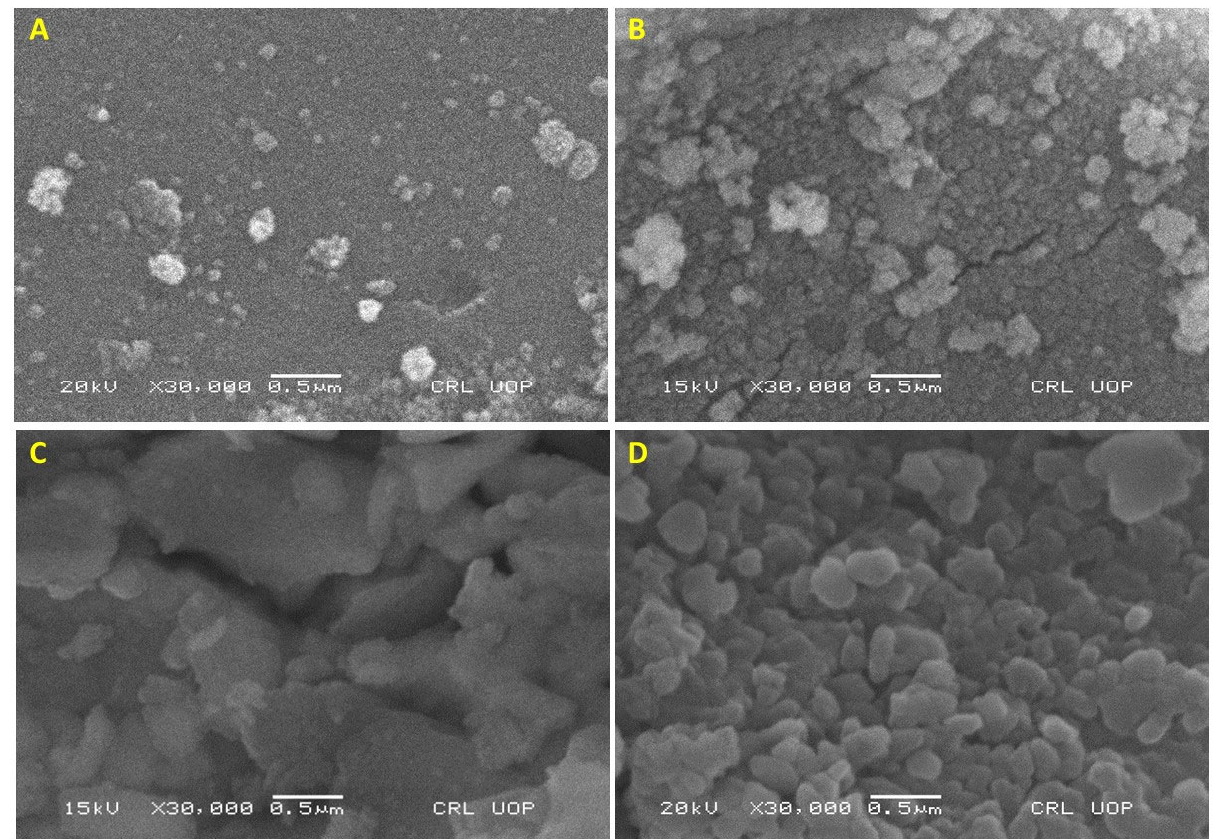
Figure 2. SEM micrographs of NiO ‐ SnO 2 NCs calcined at ( A ) 100 °C, ( B ) 300 °C, ( C ) 600 °C, and ( D ) 900 °C. The magnification and scale bar are indicated.